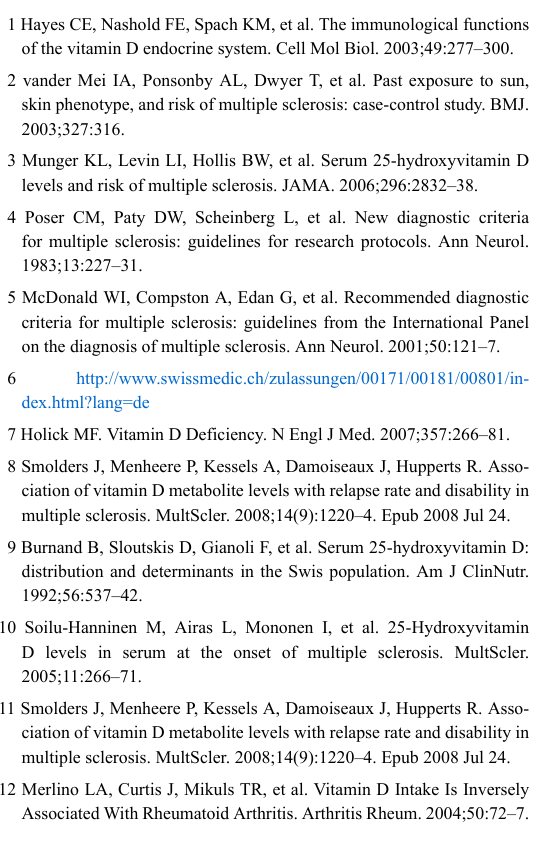
Low disease activity group (n =